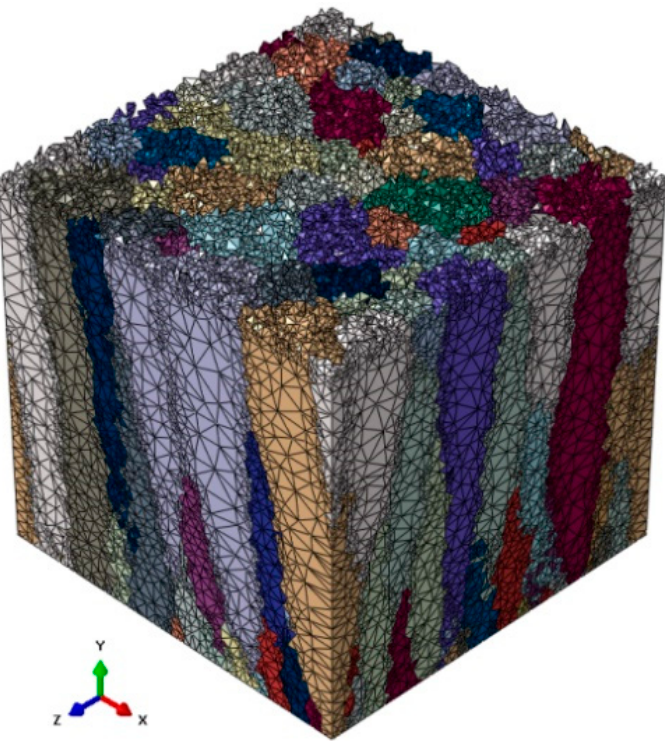
Figure 11. Finite element mesh of the investigated TiN thin film columnar morphology.